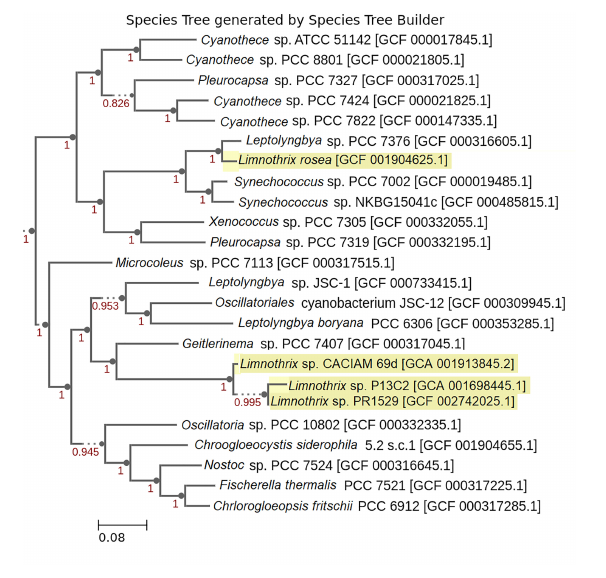
FIGURE 3 | Phylogenetic Species Tree based on genomic sequences. Limnothrix strains are highlighted with a yellow background. The numbers presented are confidence values used by FastTree 2 (Price et al., 2010) to estimate maximum likelihood. GenBank and RefSeq assembly accessions are provided within the